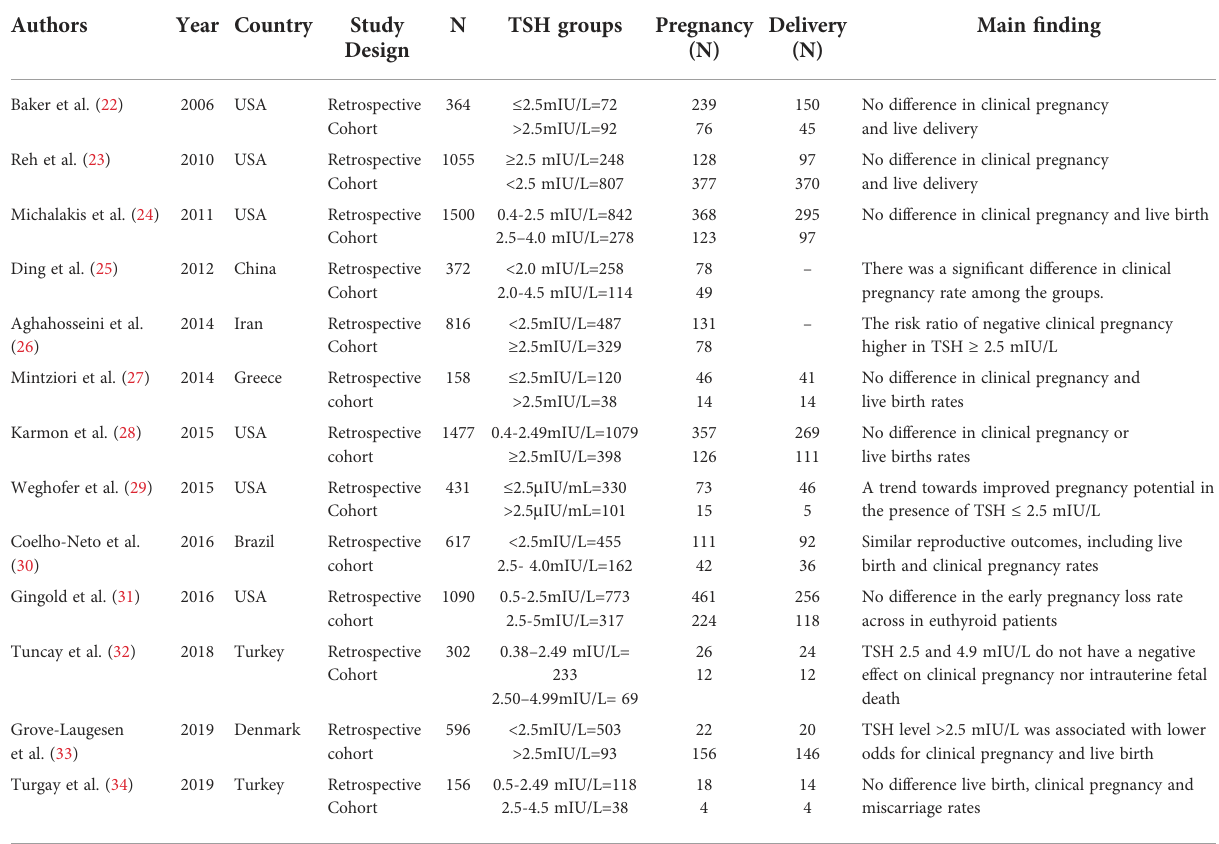
TABLE 4 Summary of evidence of the studies